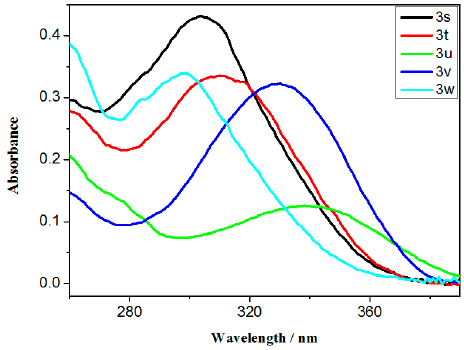
Figure 6. The absorption spectra of compounds 3 ( s – w ).